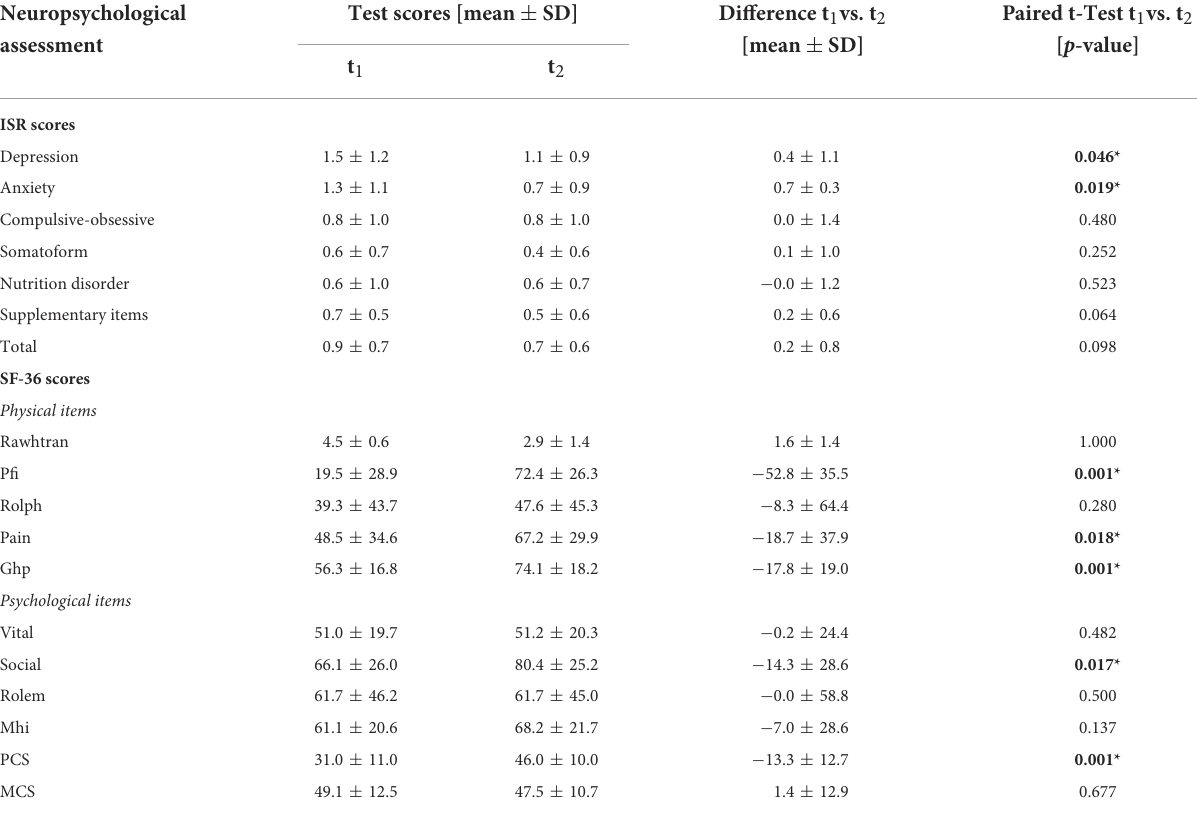
TABLE 2 Cognitive performance of the cohort ( n = 21) in the subacute interval after the onset of spontaneous subarachnoid hemorrhage (t 1 ) and at 6-month follow-up (t 2 ).